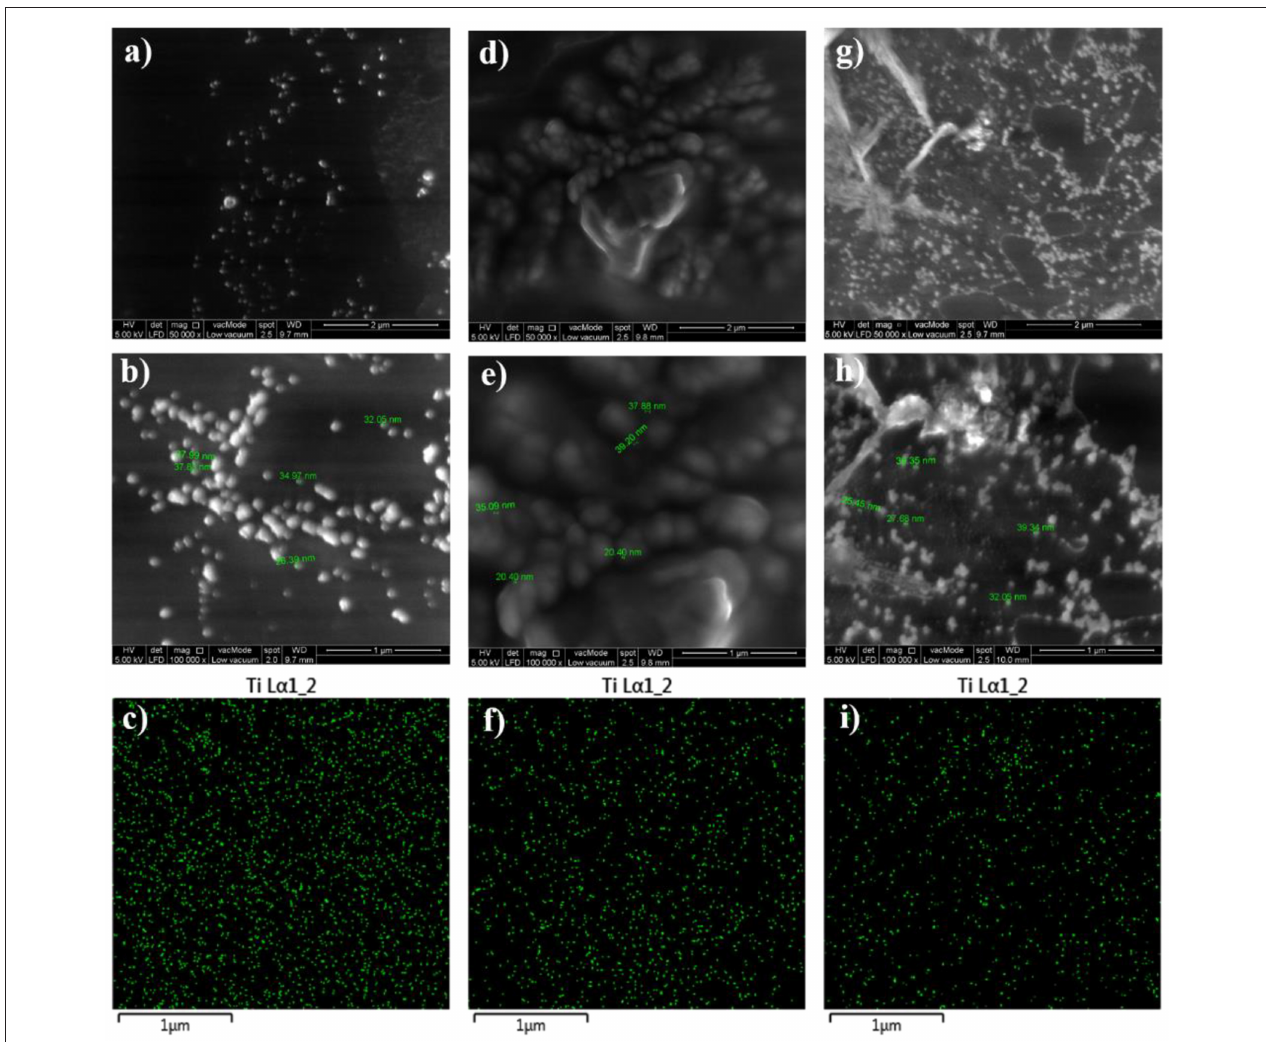
FIGURE 2 | FESEM images at x50000 and x100000 magnifications together with EDX mapping images for ET1 (a–c) , ET2 (d–f) , and ET3 (g–i)